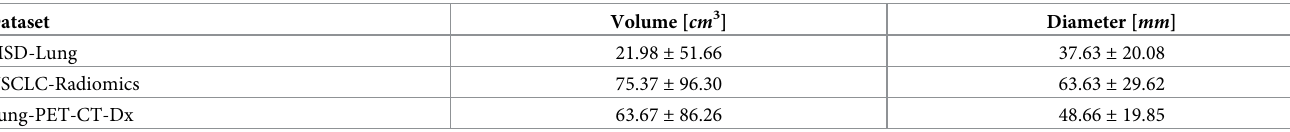
Table 1. Tumor sizes of the three